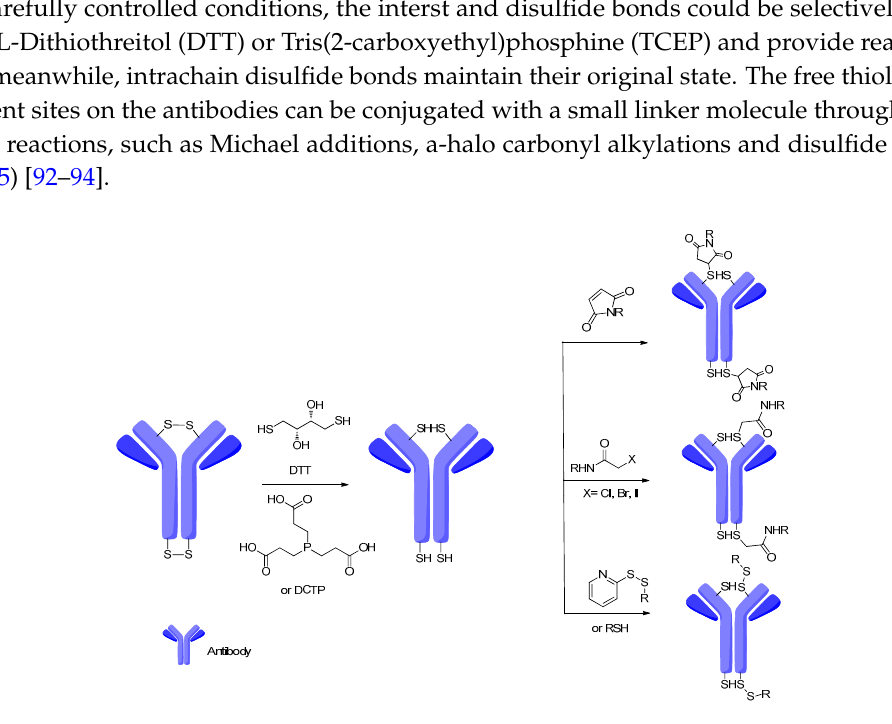
Figure 15. The disulfides of cysteines on the antibody were reduced by DL-Dithiothreitol (DTT) or Tris(2-carboxyethyl)phosphine (TCEP) and the thiols react with maleimide, halogenoalkane, disulfide or thiol compounds.